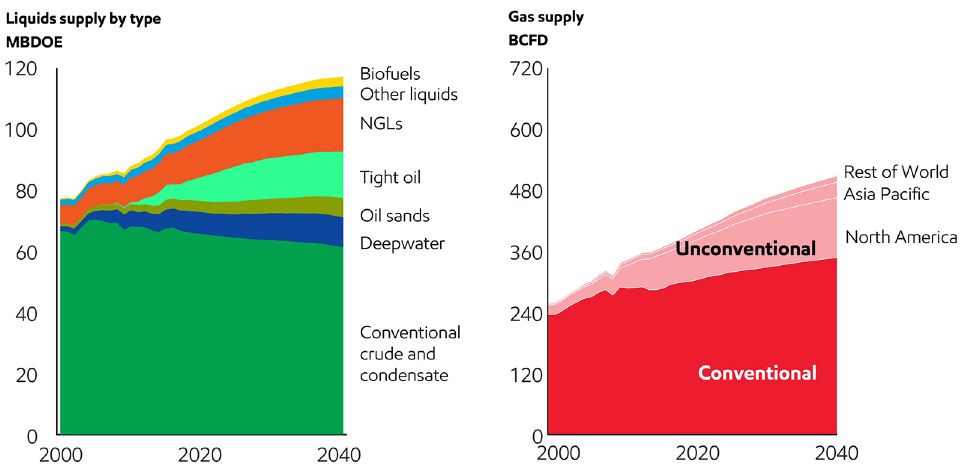
Fig. 12. – Global liquids supply by type in million barrels per day oil equivalent and gas supply by type and region in billion cubic feet per day, 2000–2040 (Source: ExxonMobil, 2017).